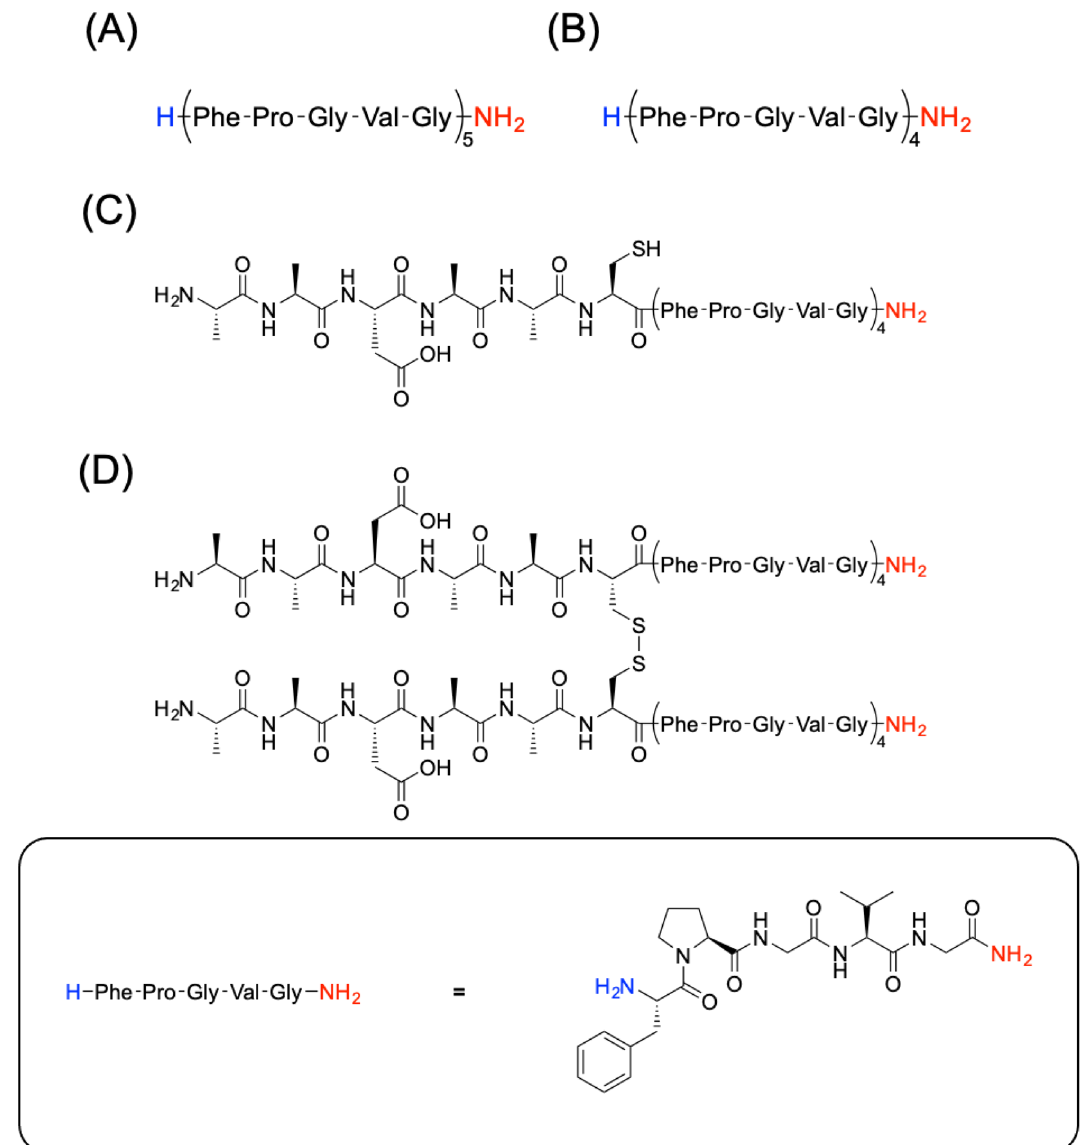
Figure 1. Chemical structures of the synthesized peptide analogues. The chemical structures of ( A ) F5, ( B ) F4, ( C ) AADAAC-F4, and ( D ) AADAAC-F4-dimer are shown. The C -terminus of each peptide was capped with an amide group to avoid side reactions (represented using red